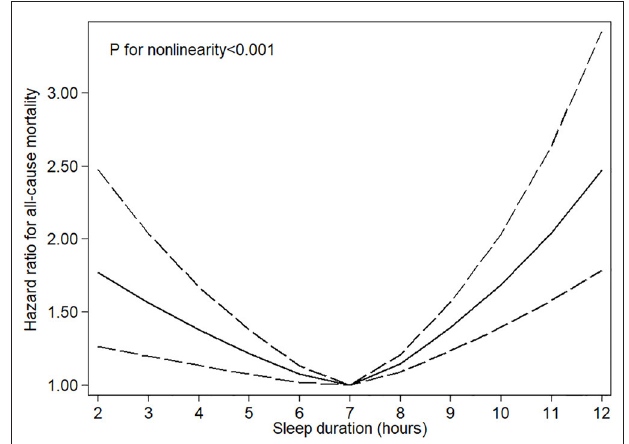
FIGURE 1 | Restricted cubic spline models for sleep duration and risk of all–cause mortality. Knots were placed at the 10th, 50th, and 90th percentiles of sleep duration. Results were adjusted for age, sex, race/ethnicity, education, physical activity, drinking and smoking status, HEI − 2015 scores, body mass index, family history of diabetes mellitus and heart disease, history of diabetes, heart disease, and cancer.